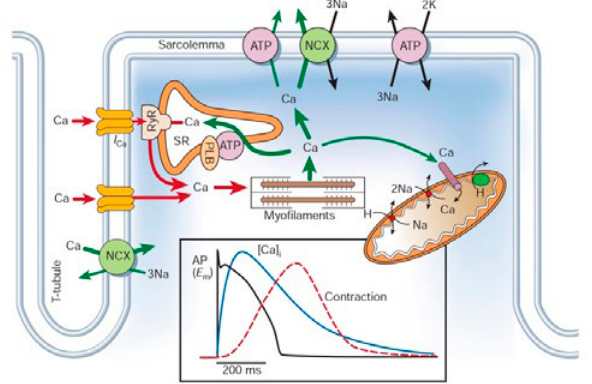
Figure 13. Ca 2+ transport in ventricular cardiac myocytes. ATP: ATPase. NCX: Na + /Ca 2+ exchange, SR: sarcoplasmic reticulum. Bers DM. Cardiac exitation-contraction coupling. 31 Nature 2002; 415 :198-205